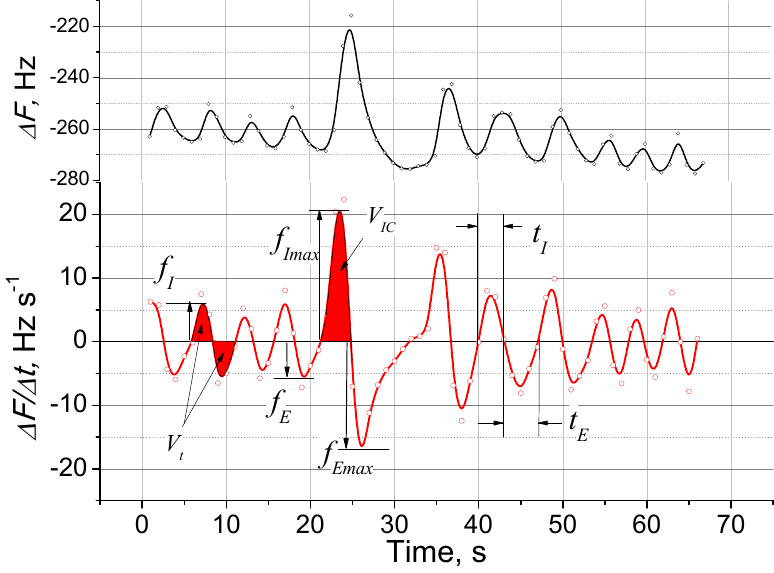
Figure 6. Response of the QCM sensor modified with a (PDDA + /TSPP − ) breath (upper plot) and the first derivative (bottom plot). Signal features used to characterize the respiratory activity are shown by arrows.